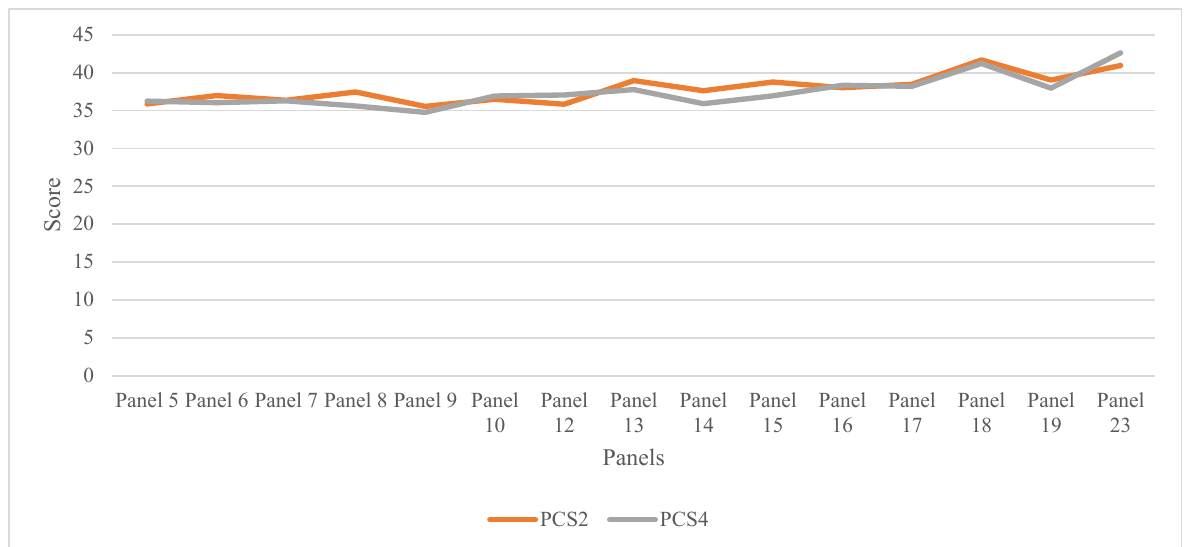
Figure 1. The trend of mental component score (MCS) domain: Panels 11, 20, 21, and 22 are not shown in the graph due to an incomplete record of HRQOL. MCS2: mental component score in round 2, MCS4: mental component score in round 4.